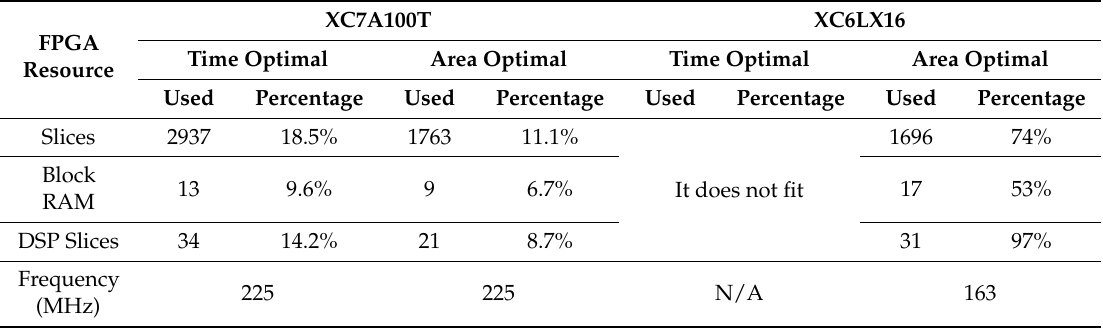
Table 3. FPGA implementation